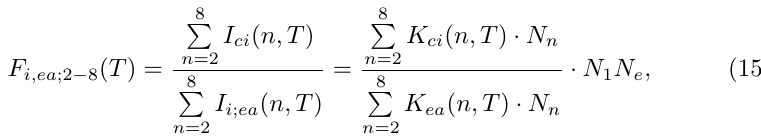
Fig. 2. Behavior of the quantity F i ; ea (2; 8) given by Eq. (15), as a function of height